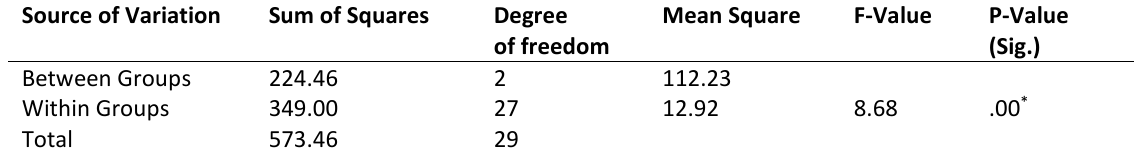
Table 7. One way analysis of variance (Anova) results among judo, taekwondo and boxing players with regard to the sub-parameter preparation